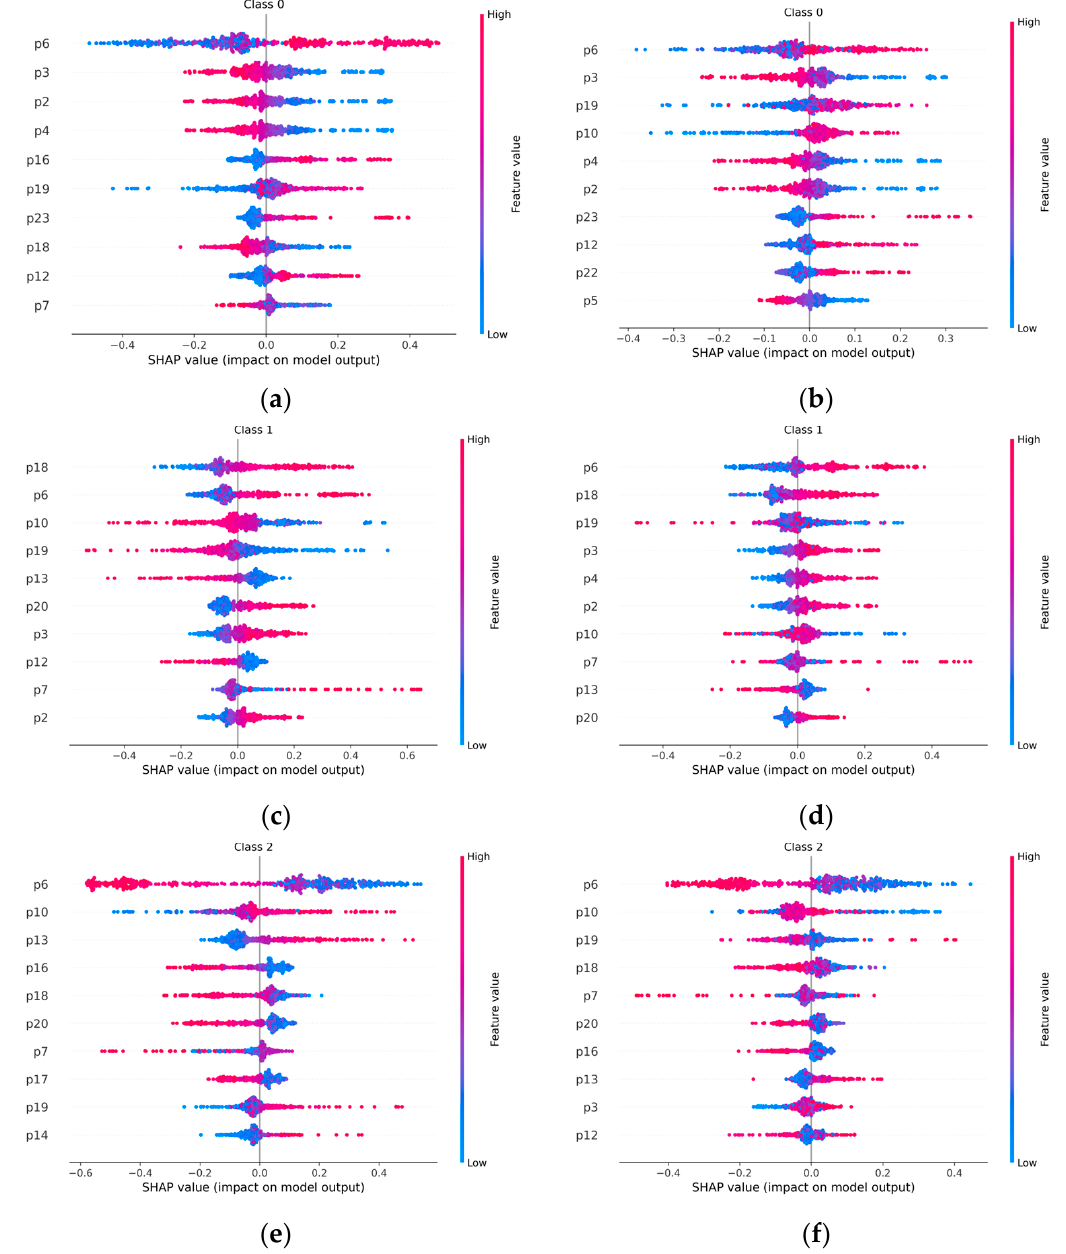
Figure 6. SHAP values: ( a ) SVM Shapley values for class 0 (normal); ( b ) kNN Shapley values for class 0 (normal); ( c ) SVM Shapley values for class 1 (IR damage); ( d ) kNN Shapley values for class 1 (IR damage); ( e ) SVM Shapley values for class 2 (OR damage); and ( f ) kNN Shapley values for class 2 (OR damage).